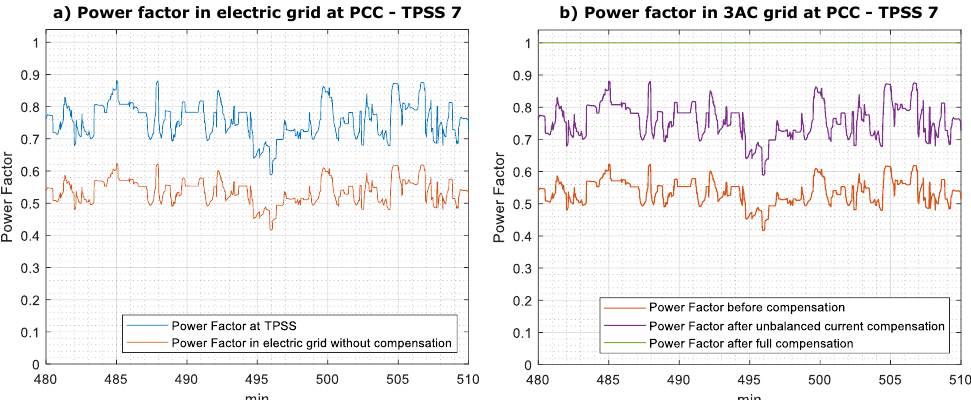
Figure 9. Power factor at substation #7 with and without compensation: ( a ) single-phase; ( b ) three-